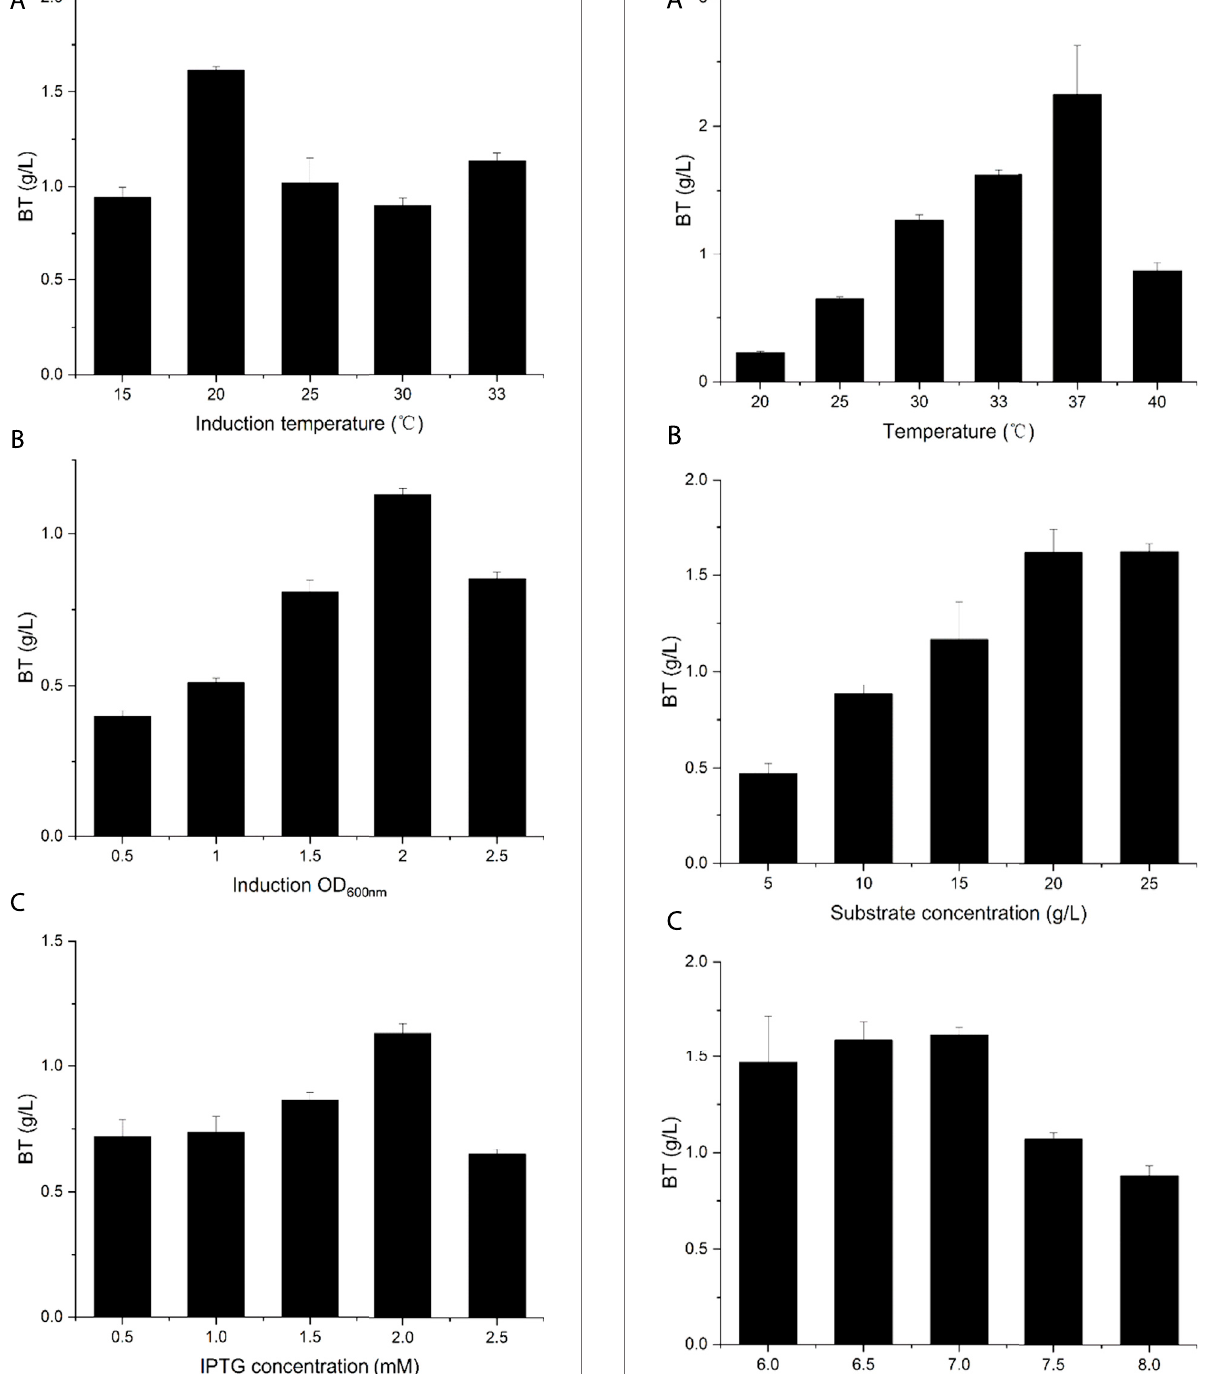
Frontiers in Bioengineering and Biotechnology |